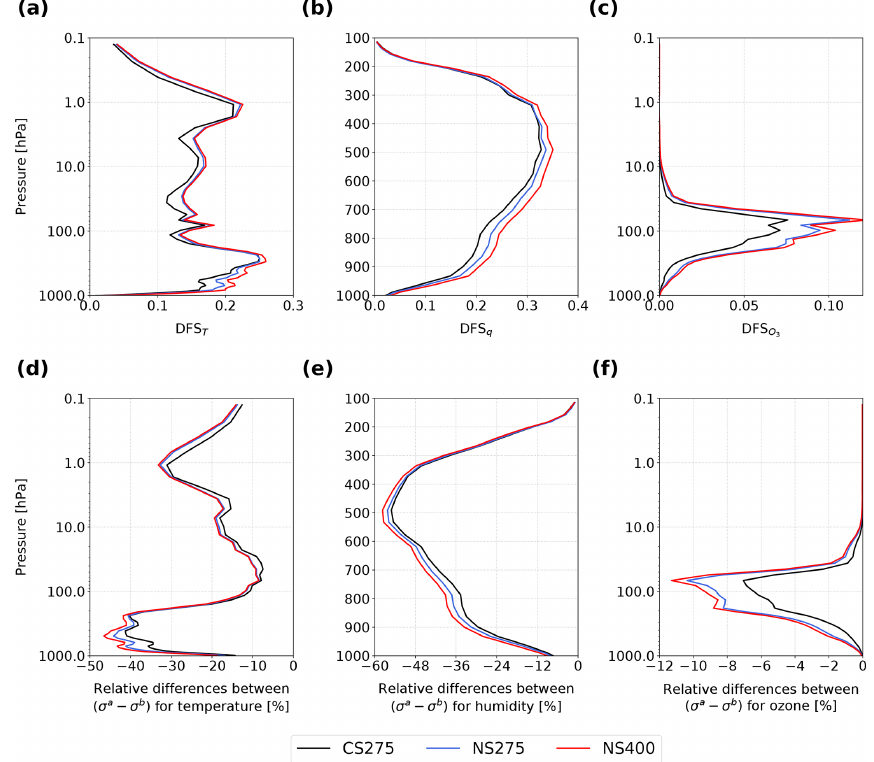
Figure 12. Vertical profiles of mean DFS for temperature (a) , humidity (b) and ozone (c) with respect to pressure and vertical profiles of relative difference between analysis-error standard deviation ( σ a ) and background-error standard deviation ( σ b ) for temperature (d) , humidity (e) and ozone (f) with respect to pressure. These results are derived from 1D-Var data assimilation experiments over the set of 6123 atmospheric profiles with Collard’s channel selection (275) with a black line, the new channel selection (275) with a blue line and the new channel selection (400) with a red line. Note that the vertical profiles of DFS q (b) and relative differences for humidity (e) are shown between 1000 and 100hPa.